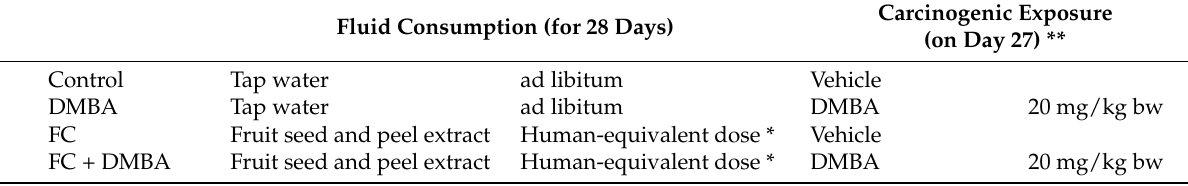
Table 1. Treatment